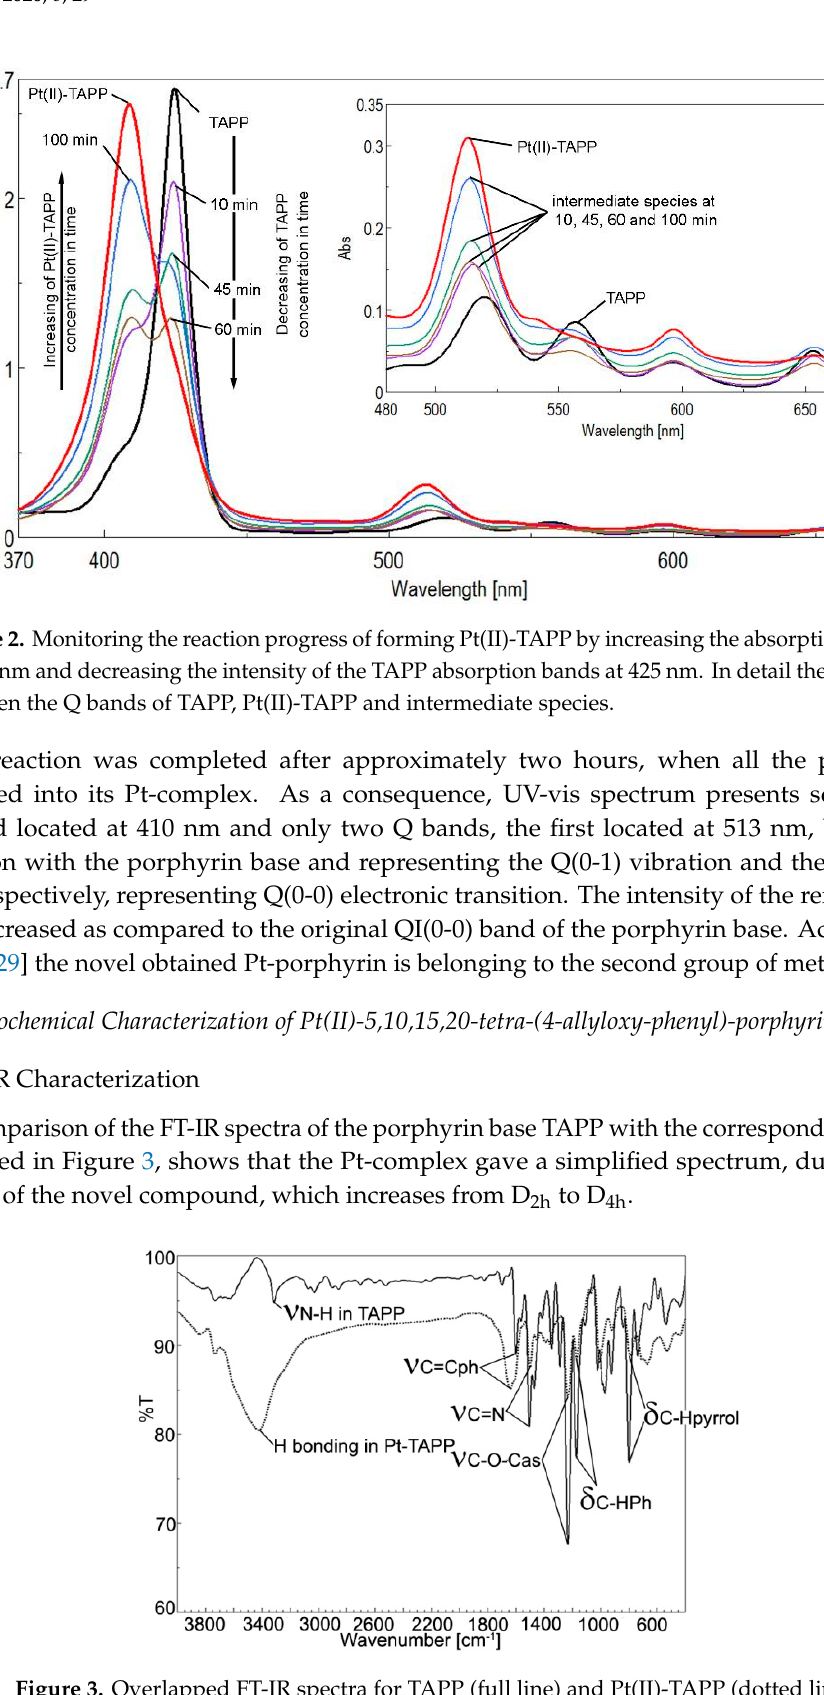
Figure 3. Overlapped FT-IR spectra for TAPP (full line) and Pt(II)-TAPP (dotted line).